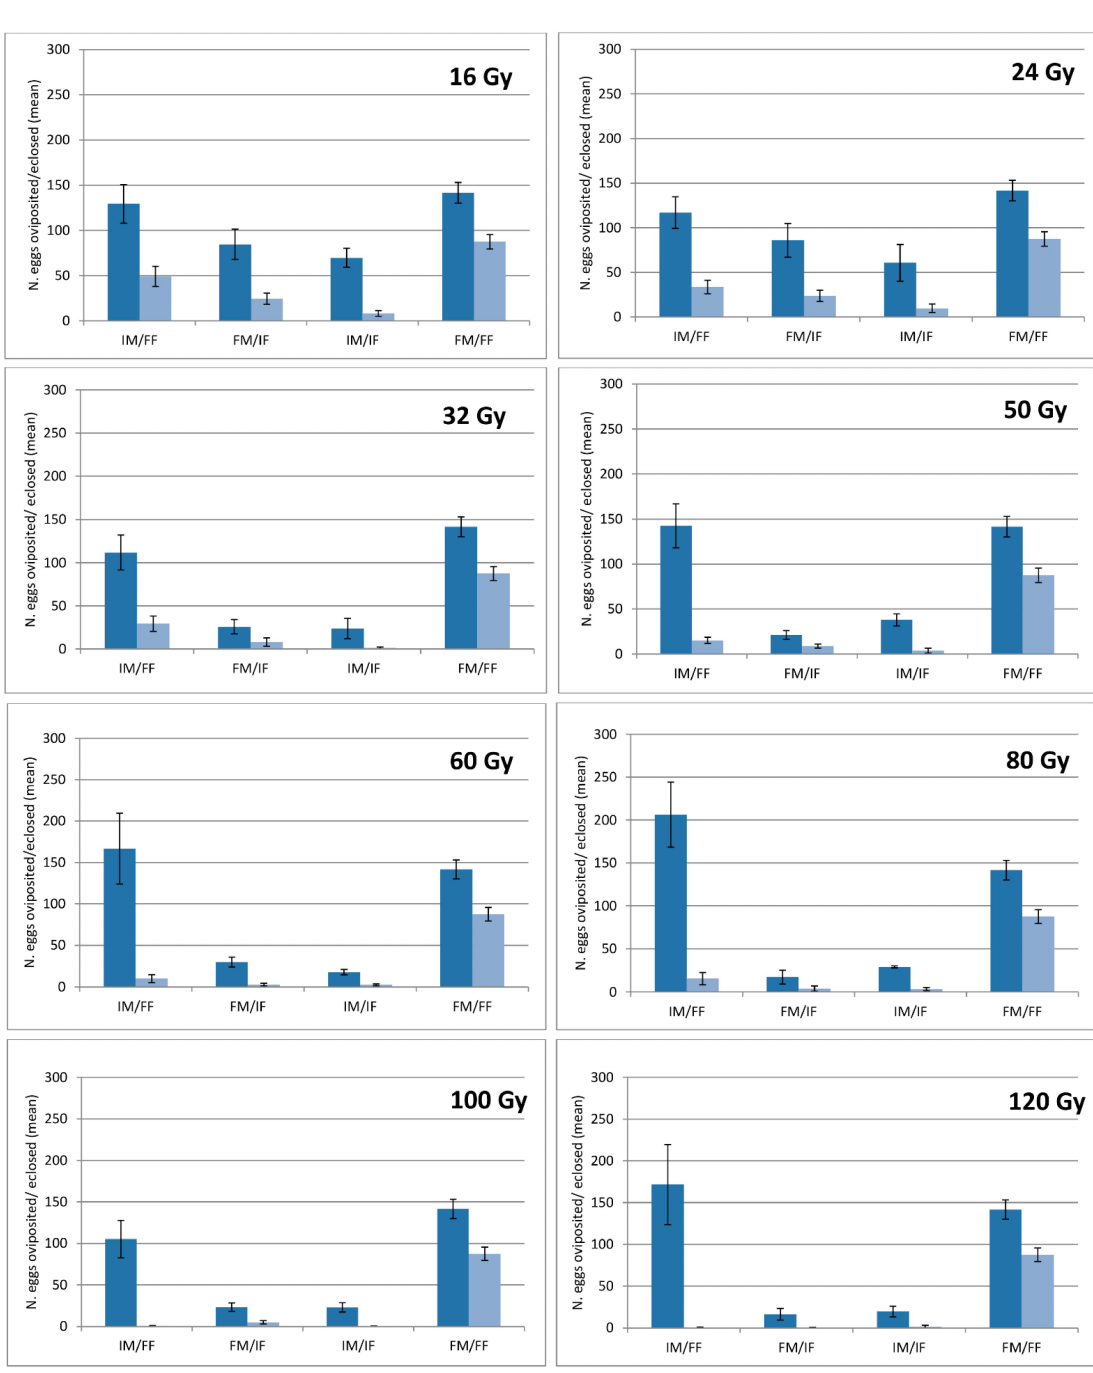
Figure A1. Comparisons of fecundity (dark blue bars) and fertility (light blue bars) values (mean ± s.e.) of B. hilaris for the 3 treatments and control in the irradiation screening from 16 to 120